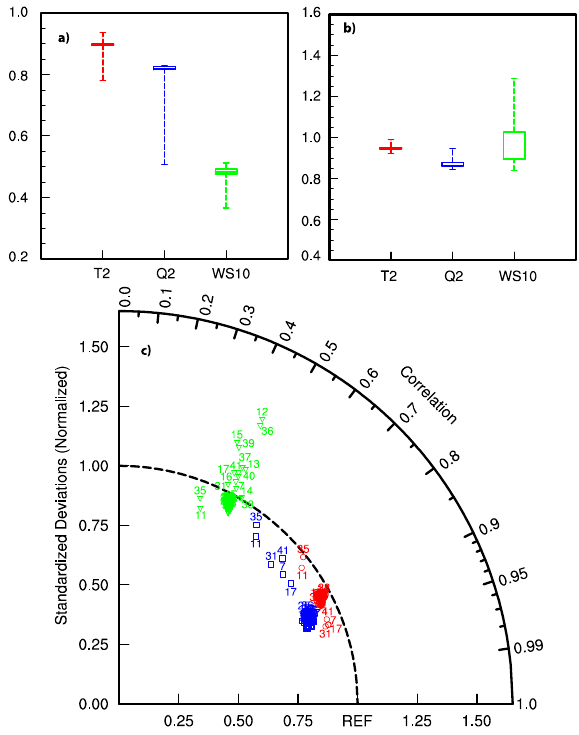
Figure 4. Same as Figure 2, but for the one-week study period in July.